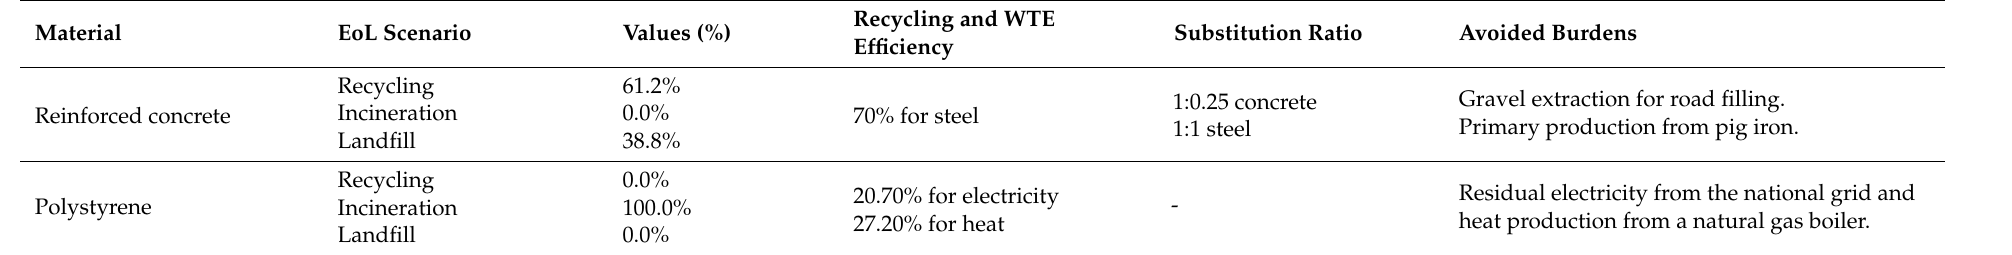
Table A2. EoL scenarios, benefits, and